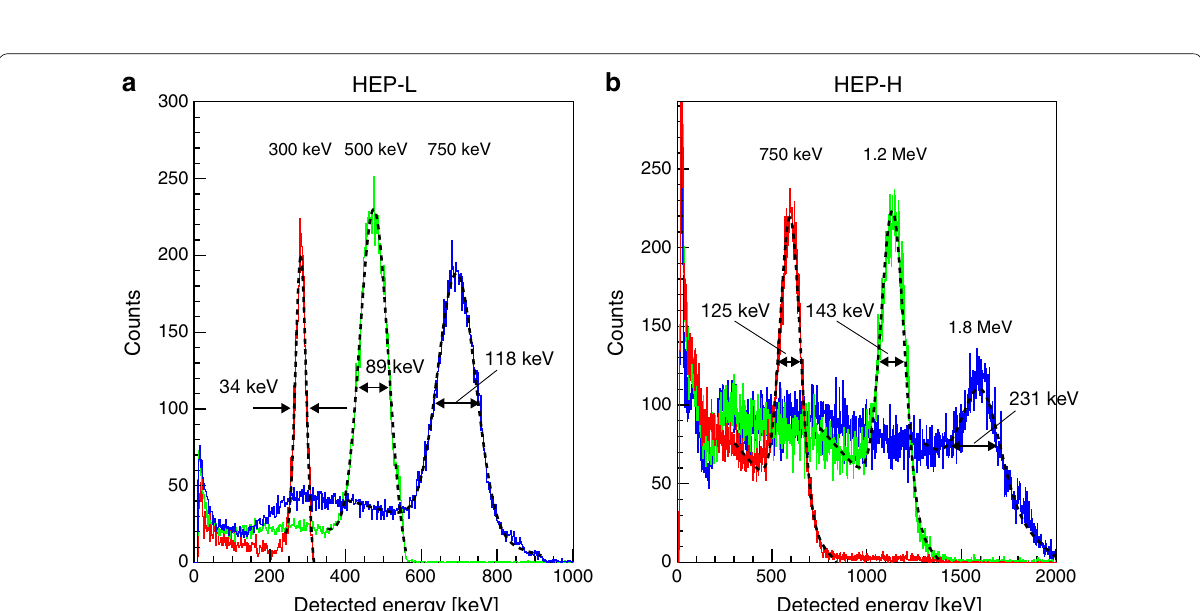
Fig. 10 Electron spectra measured with HEP flight model. a Spectra detected by HEP-L show electrons with 300, 500, and 750 keV of energy. b Spectra detected by HEP-H show electrons with energy of 750 keV, 1.2 MeV, and 1.8 MeV. Dotted line shows result of fitting with Gaussian function in addition to straight